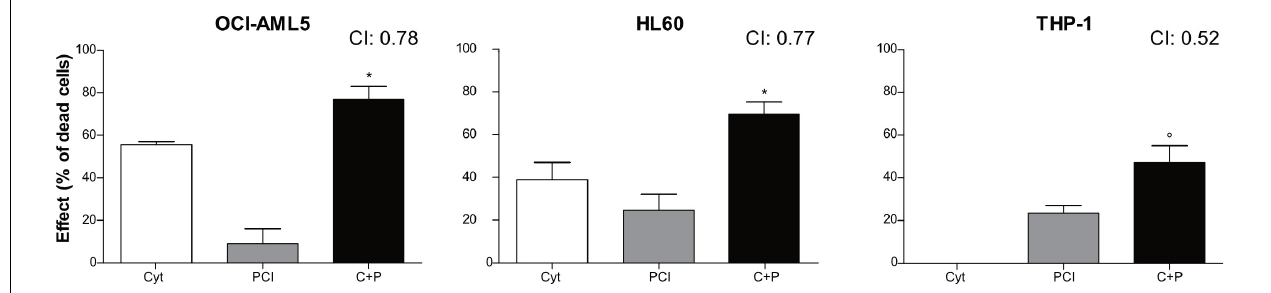
FIGURE 3 | Combination treatment with cytarabine + PCI. OCI-AML5, HL60, and THP-1 cell lines were treated for 72 h with single compound and their combination. CTG assay was used to assess the effect of each treatment on the cell culture viability. The bar graph represents the effect of one of the eight concentrations tested. CI values are shown for each combination. The results are presented as mean ± SEM from two independent experiments. Asterisk (*) indicates significance of combination treatment versus PCI, circle ( ◦ ) indicates significance of combination treatment versus cytarabine. One symbol, p < 0.05, Student’s t -test. Cyt and C, cytarabine; P, PCI; CI, combination